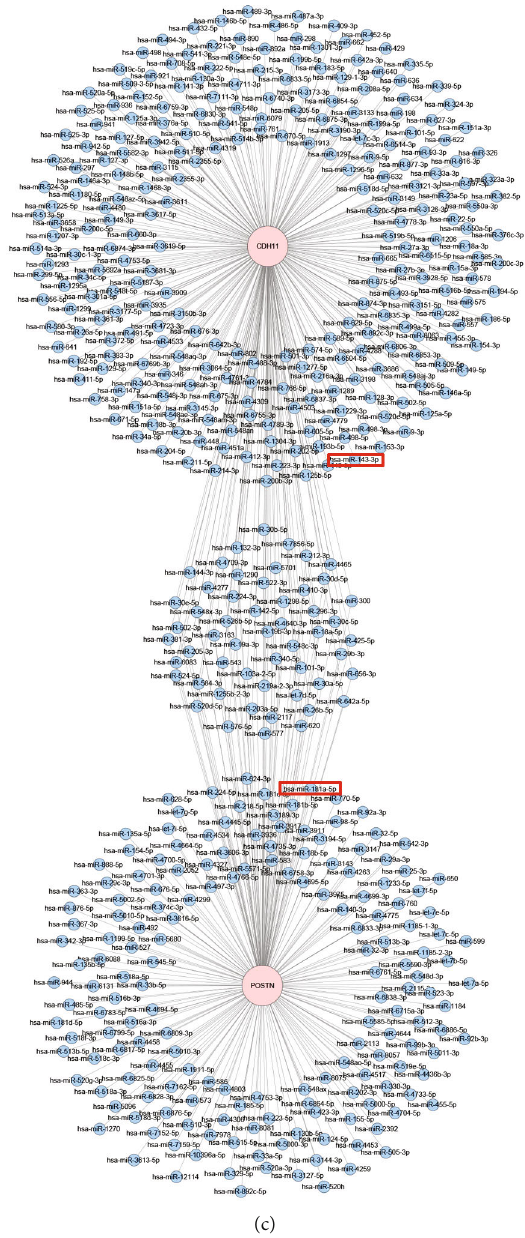
Figure 5: Gene correlation network analysis to identify hub genes of HDFs in the diabetic skin. (a) The relationships among the di ff erentially expressed mRNAs and miRNAs. The relationship of protein-protein interactions (PPI), coexpression, coexistence of PPI and coexpression, and predicated miRNA-mRNA regulation is presented by di ff erent line types. The MCODE cluster suggested a close relationship of POSTN and CDH11 in a network cluster view. (b) The CytoHubba average rank of di ff erentially expressed miRNAs and mRNAs. The smaller the average rank is, the higher the importance of the gene is. (c) The miRNA network that may a ff ect the expressions of hub protein-coding genes (POSTN, CDH11). The cluster in the middle of graph (c) shows the miRNAs that control the expression of both genes. The red boxes indicate the di ff erentially expressed miRNAs of miR-181a-5p and